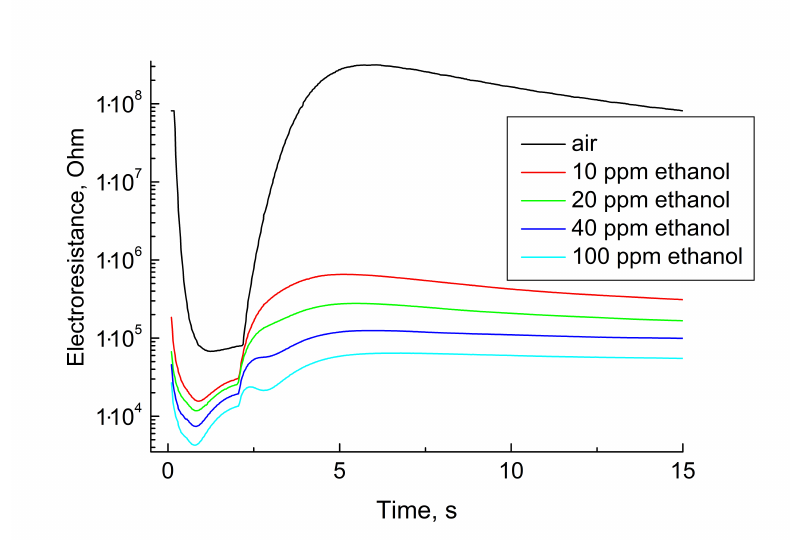
Figure 8. Electrical resistance of the sensor as a function of time during one cycle of measurements at determining different C 2 H 5 OH